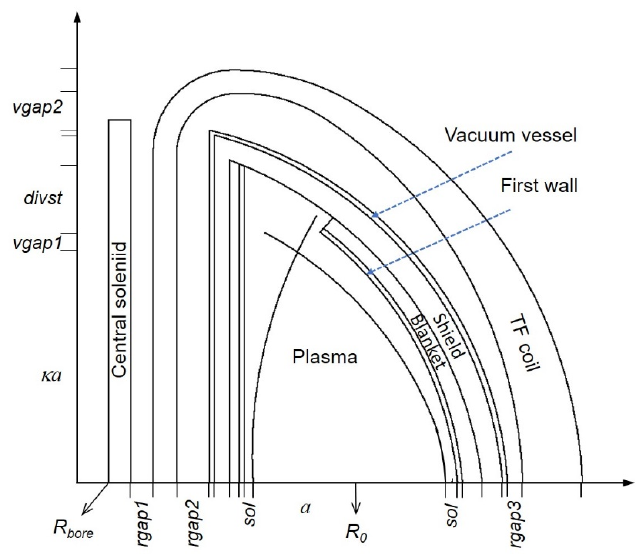
Figure 1. Cross section of the tokamak fusion